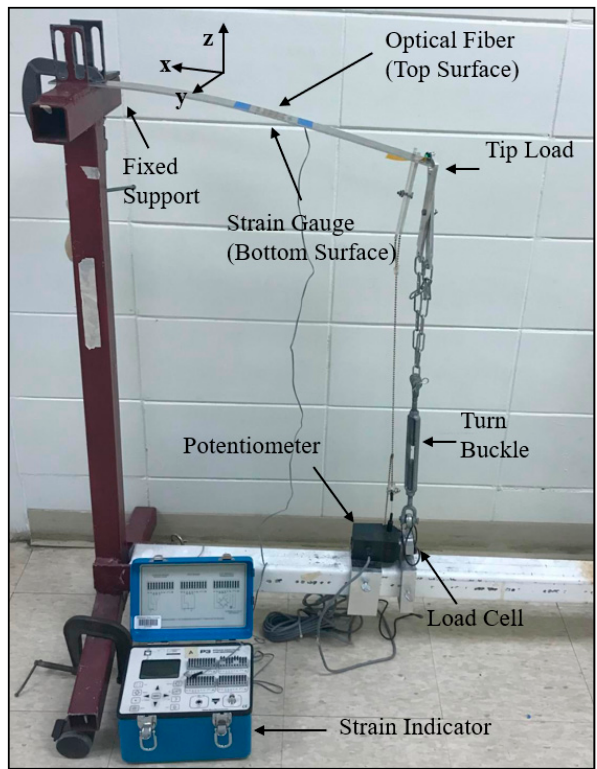
Figure 4. Beam testing apparatus.